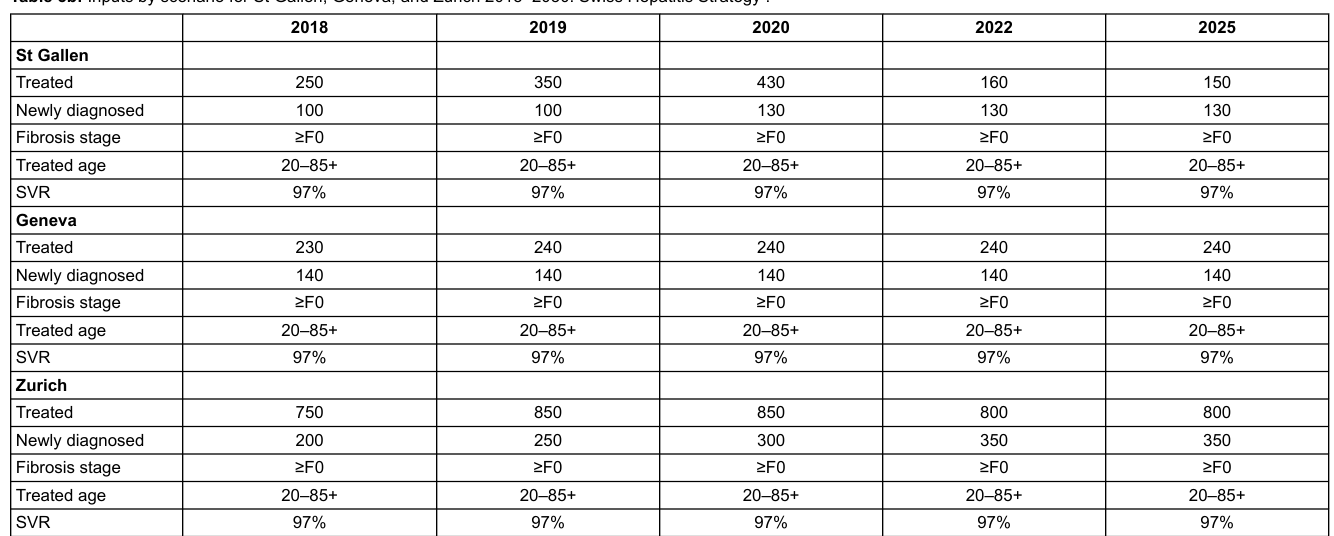
Table 3b: Inputs by scenario for St Gallen, Geneva, and Zurich 2015–2030: Swiss Hepatitis Strategy *